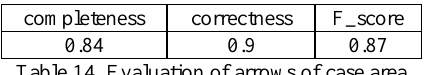
Table 14. Evaluation of arrows of case area